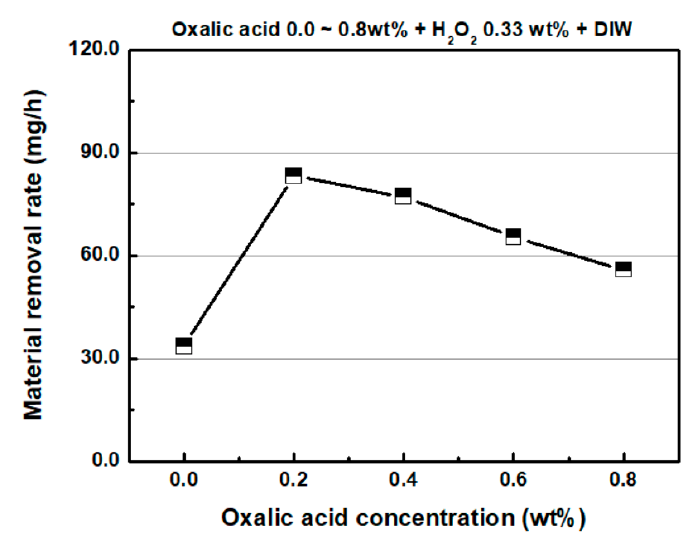
Figure 10. Material removal rate as a function of oxalic acid concentration (H 2 O 2 concentration: 0.33 wt %).